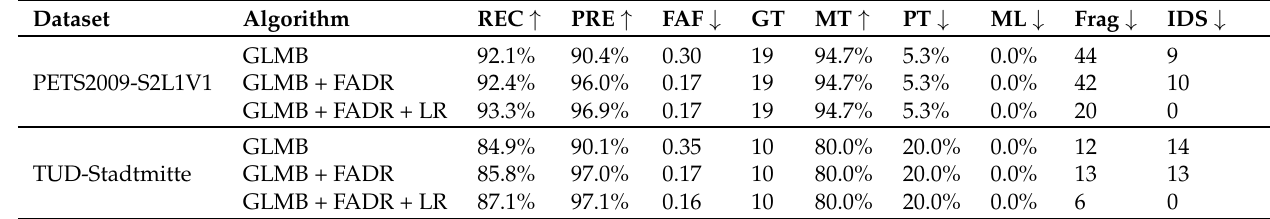
Table 3. Ablation study. Results for baseline (GLMB), GLMB + FADR and GLMB + FADR + LR algorithm on PETS2009 S2L1V1 and TUD-Stadtmitte